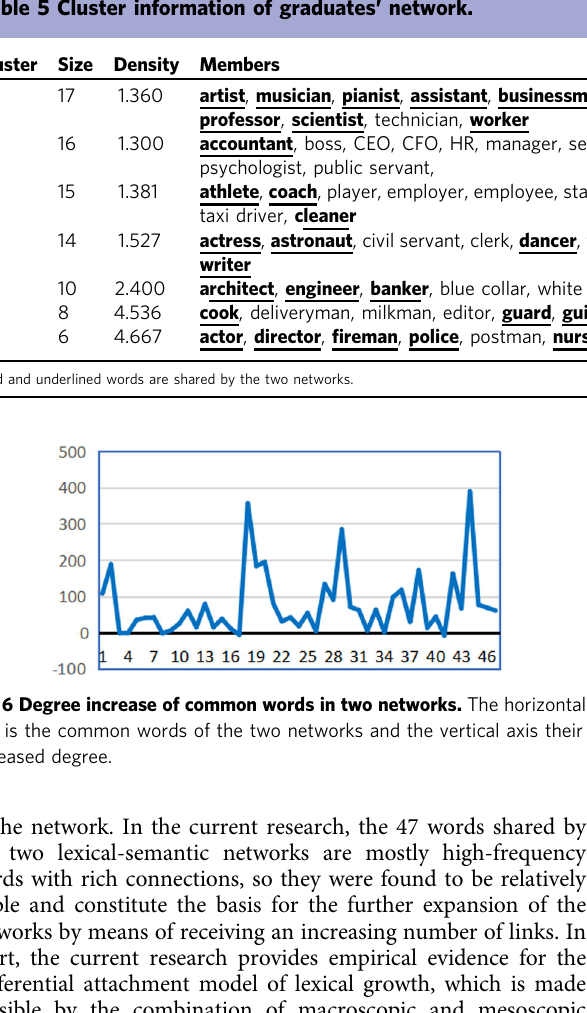
Table 5 Cluster information of graduates ’ network.